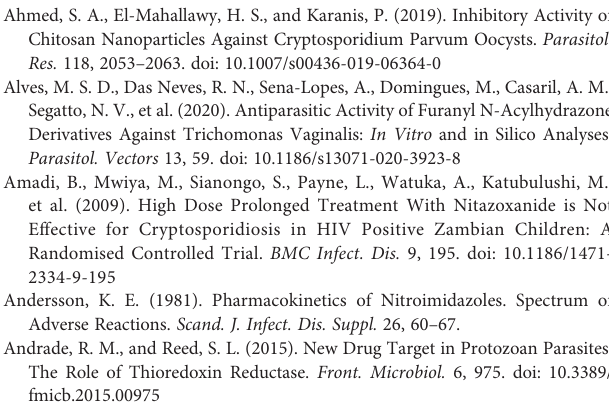
Supplementary Table 1 | List of natural compounds with antiprotozoa activity.